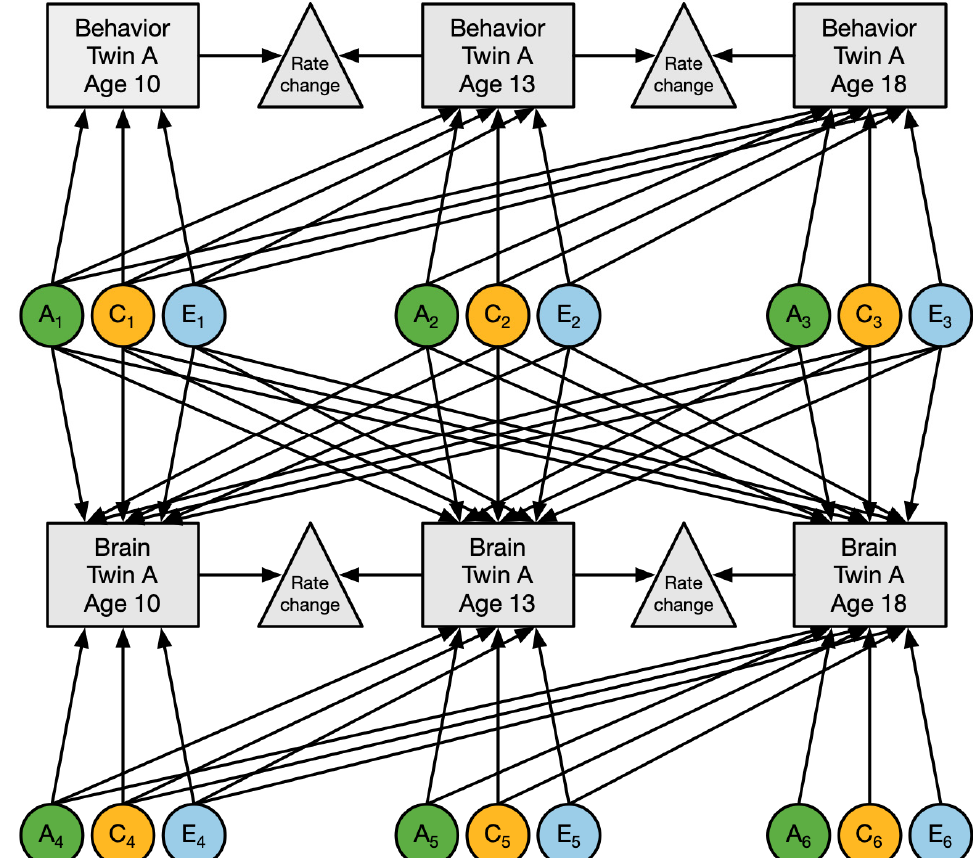
Figure 4. Longitudinal structural equation model applied to the longitudinal data on brain and behavior. Boxes represent observed measures of behavior and/or brain features; circles represent the latent factors for additive genetic (blue), common environment (orange), and unique environment (green). Path coefficients between the latent factors and observed measures are estimated by the model. For simplicity, this model is shown for only one member of the family. The full model includes three family members, where latent genetic factors between family members are correlated depending on their relationship (i.e., correlation of 1.0 for MZ twins, 0.5 for DZ twins and between twin and sibling pairs), common environmental factors between family members are always shared (i.e., correlation of 1.0), and unique environment factors are uncorrelated by definition.